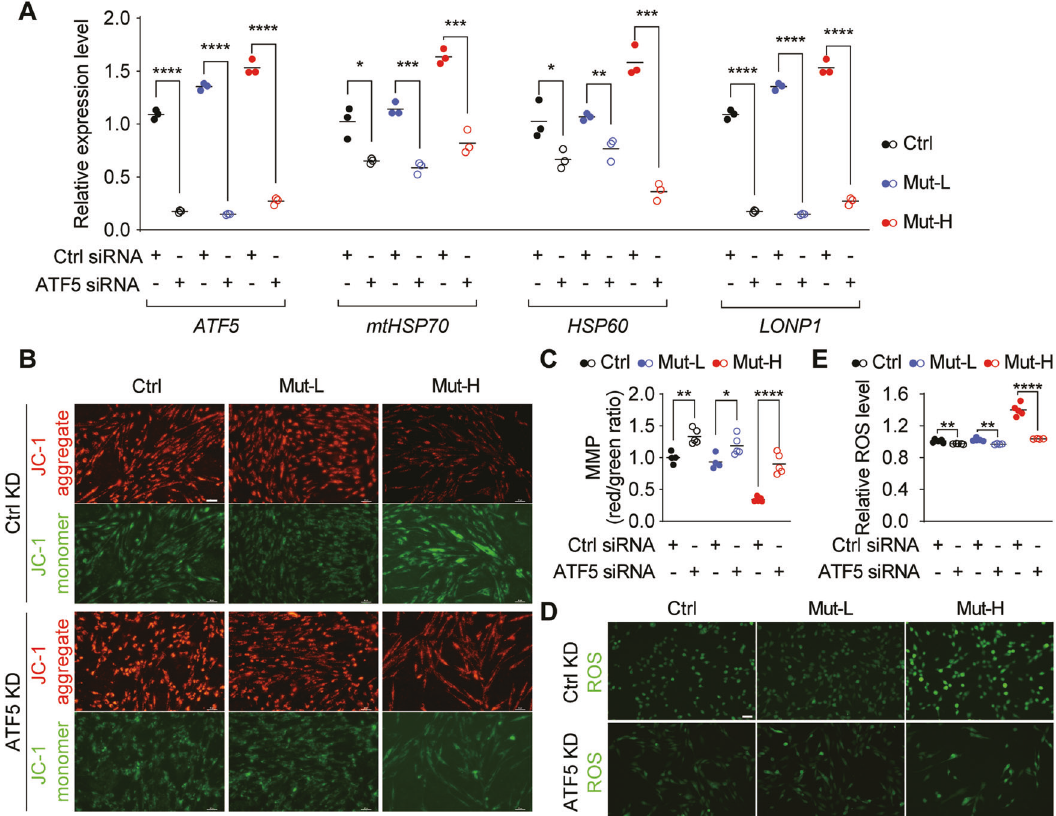
Fig. 5 ATF5 knockdown reversed mitochondrial function in Mut-H USCs. A ATF5 knockdown decreased UPR mt related gene expression. USCs were transfected with siRNA speci fi c to ATF5 for 48 h and the mRNA levels of UPR mt related genes ( ATF5, HSP70, HSP60 and LONP1 ) expression were quanti fi ed by RT-qPCR. B Mitochondrial membrane potential was increased by ATF5 knockdown. USCs were transfected with siRNA speci fi c to ATF5 for 48 h and mitochondrial membrane potential was measured using fl uorescence probe JC-1 assay system. Red color indicates cells with normal mitochondrial membrane potential while green indicates cells with loss of mitochondrial membrane potential. C Quanti fi cation plot for B . D Intracellular ROS was decreased by ATF5 knockdown. USCs were transfected with siRNA speci fi c to ATF5 for 48 h and stained with DCFH-DA. Green color indicate ROS-positive cell population. E Quanti fi cation plot for D . * P < 0.05, ** P < 0.01, *** P < 0.001, **** P < 0.0001. Scale bar = 50